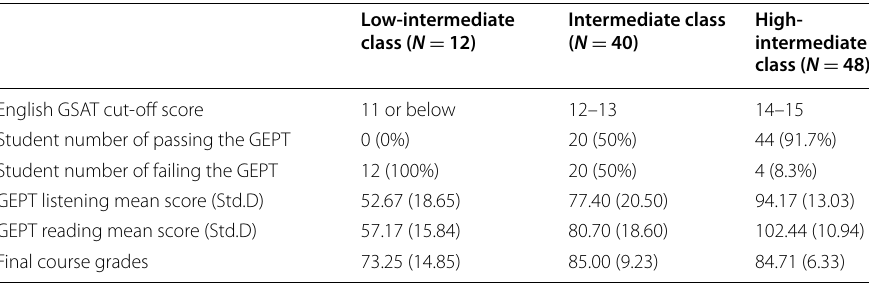
Table 6 Passing rate of the GEPT for the three‑level placement